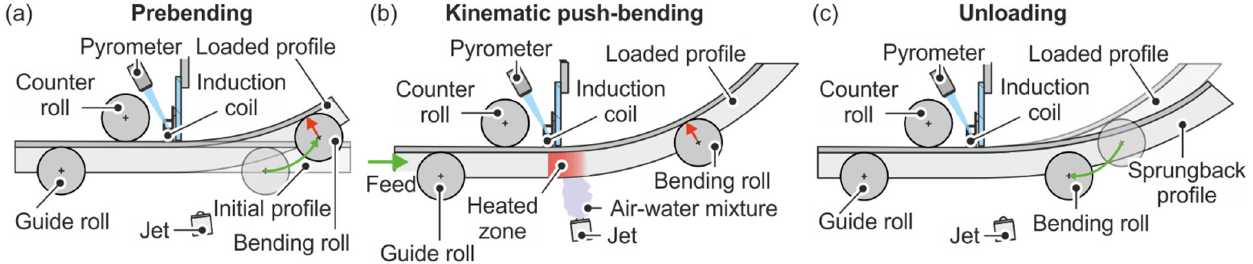
Figure 2. Process concept for ( a ) prebending phase, ( b ) kinematic push-bending phase, and ( c ) unloading phase.